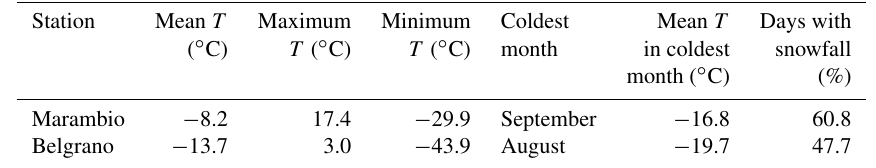
Table 3. Meteorological parameters (temperature T and snowfall) observed during 2015 at both stations. Data are provided by the World Meteorological Organization (WMO), the Argentinian Meteorological Centre and INTA’s meteorological station (Belgrano). The snowfall is based on surface synoptic observations.